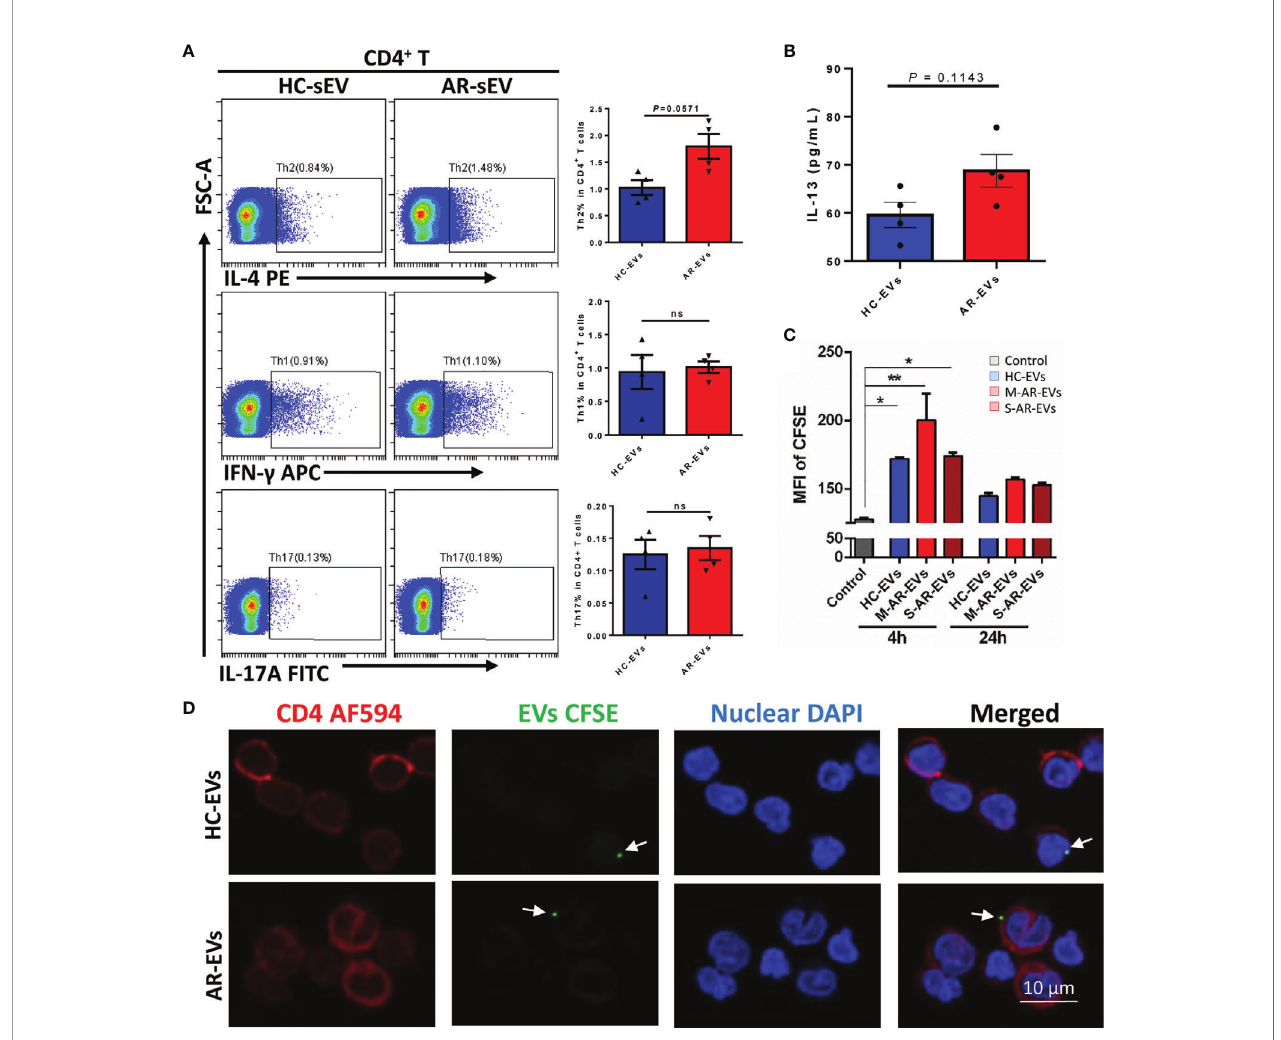
FIGURE 6 | Plasma EVs isolated from AR patients promoted Th2 differentiation in isolated CD4 + T cells. (A) The levels of Th2, Th1 and Th17 with the treatment of AR-EVs or HC-EVs. (B) The level of IL-13 in the supernatants of AR-EV-stimulated CD4 + T cells. (C) Flow cytometry analysis of the uptake effects of CD4 + T cells on HC-EVs and AR-EVs. (D) Immuno fl uorescent images showing that both HC-EVs and AR-EVs were able to adhere to CD4 + T cells. EVs, extracellular vesicles; HC, healthy control, M-AR, Mild allergic rhinitis; S-AR, Moderate-severe allergic rhinitis; Th1, type 1 T helper cells; Th2, type 2 T helper cells; Th17, type 17 T helper cells; ns, no signi fi cance. Statistical analyses were performed by Mann – Whitney U